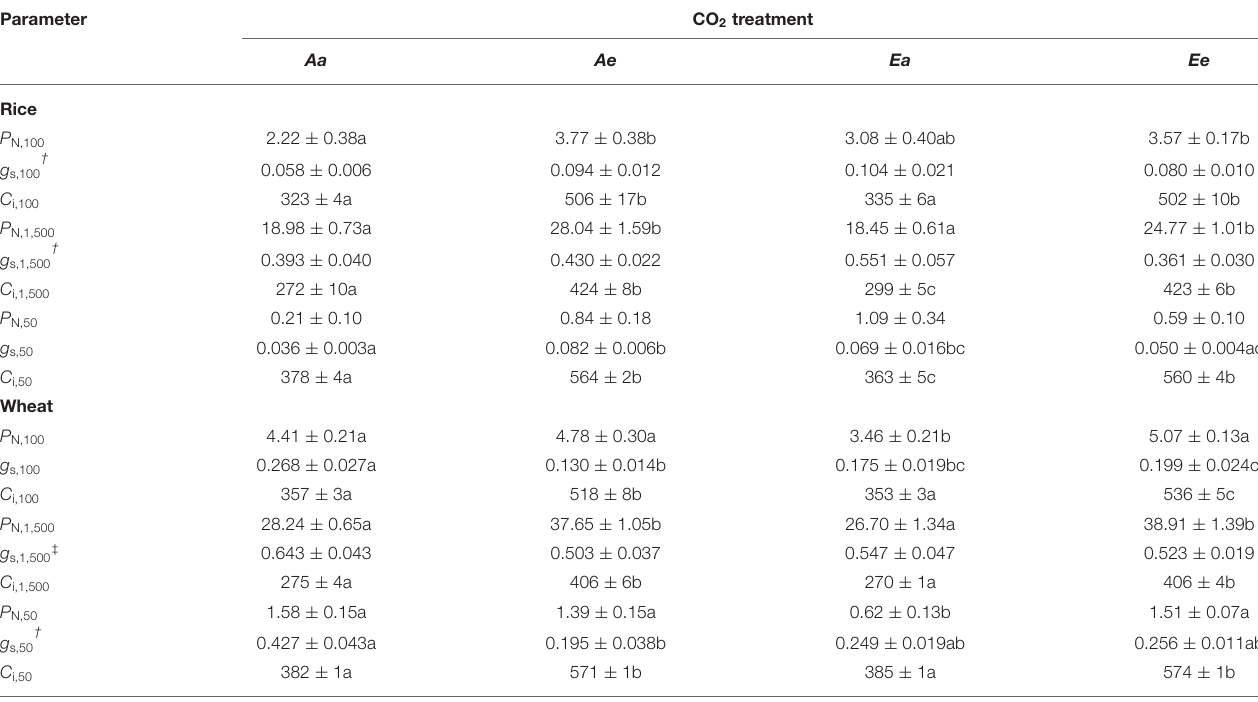
TABLE 2 | Steady-state photosynthetic rate ( P N ), stomatal conductance ( g s ), and intercellular CO 2 concentration ( C i ) reached under different light intensities in rice and wheat.